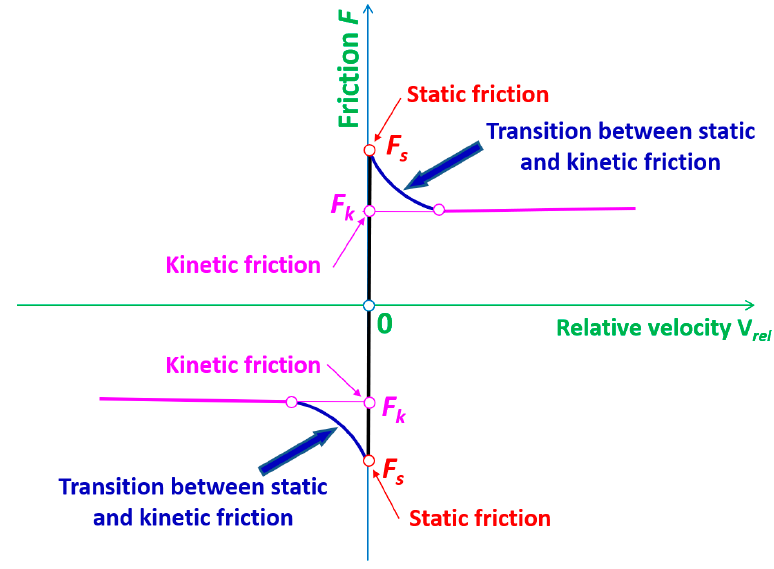
Figure 3. Friction force versus relative velocity.